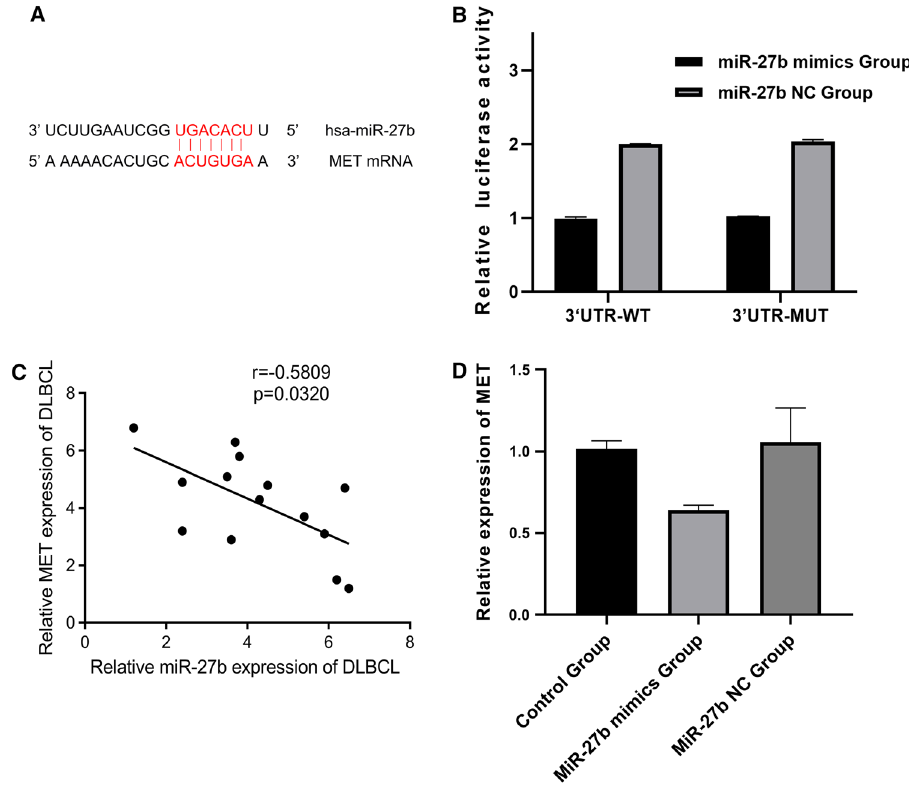
Fig. 4 miR-27b directly targeted MET. A : The paired sequence of miR-27b and MET; B : Dual-luciferase reporter analysis confirmed that miR-27b bound to MET;